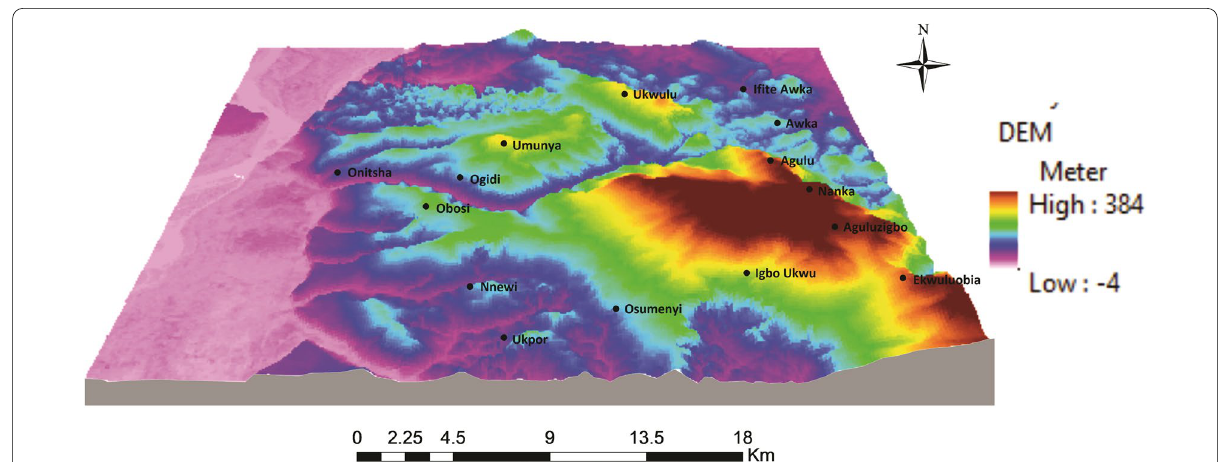
Fig. 6 Digital elevation model (DEM) of the study area where Nanka formation outcropped. Generated from NASA SRTM - 30m data